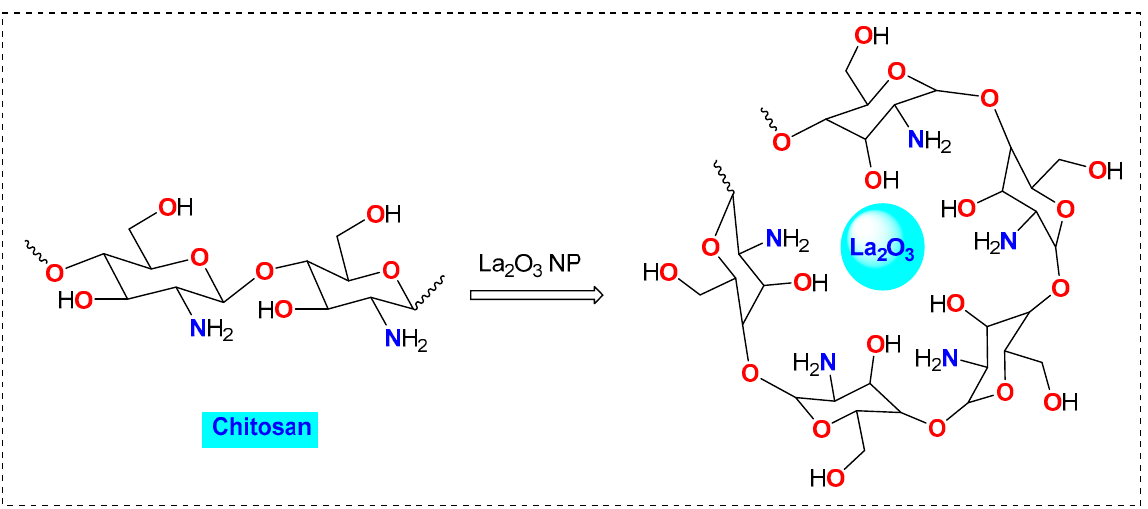
Figure 1. A simplified view of chitosan-La 2 O 3 nanocomposite.